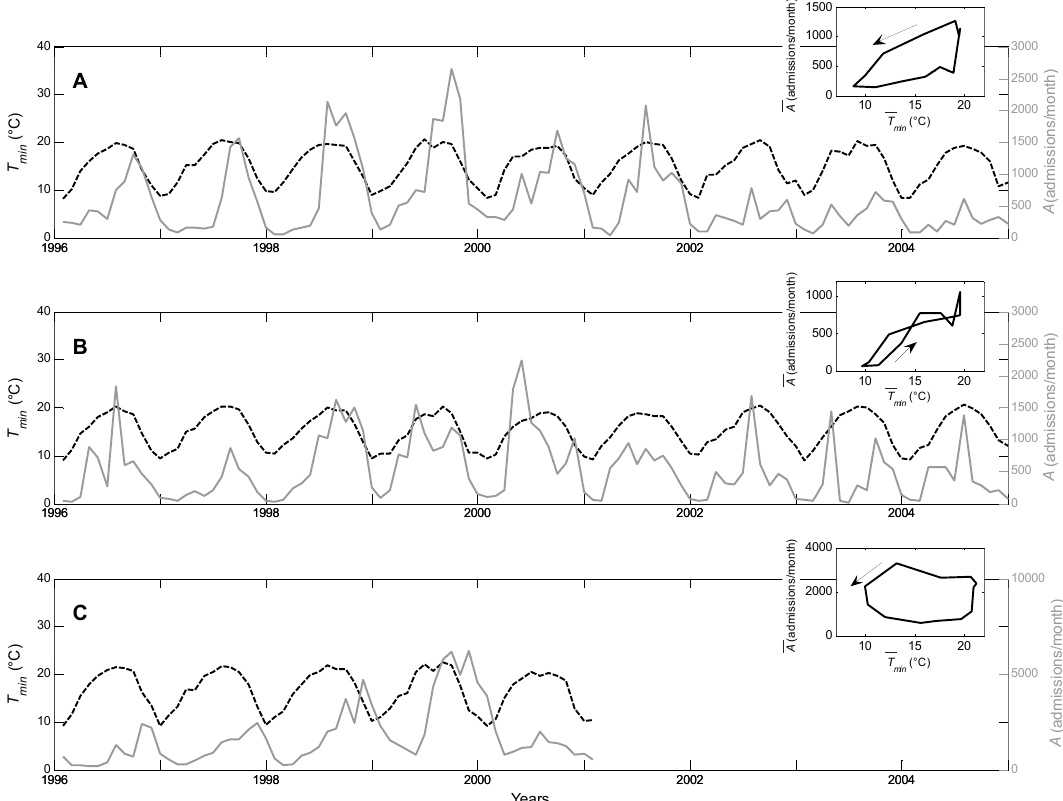
Fig. 3. Monthly malaria cases (solid gray line) and minimum temperature (dashed black line) for (A) Mpumalanga, (B) Limpopo, and (C) KwaZulu-Natal provinces. Insets describe seasonal averages of malaria cases and minimum temperature (time proceeds according to the